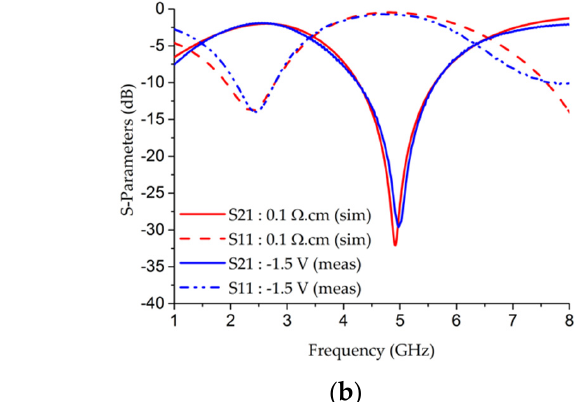
( d ) Figure 9. Top views of switchable DBRs. ( a ) DBR 1 with doped area dimensions of 0.2 mm × 0.314 mm. ( b ) DBR 2 with doped area dimensions of 1 mm × 0.314 mm. ( c ) DBR 3 with doped area dimensions of 0.2 mm × 0.836 mm. ( d ) DBR 4 with doped area dimensions of 2 mm × 1.5 mm. Measured results of switchable DBR 1 in the OFF and ON states. Table 2. Dimensions of the ScDDAs of the four demonstrators. ScDDA of DBR 1